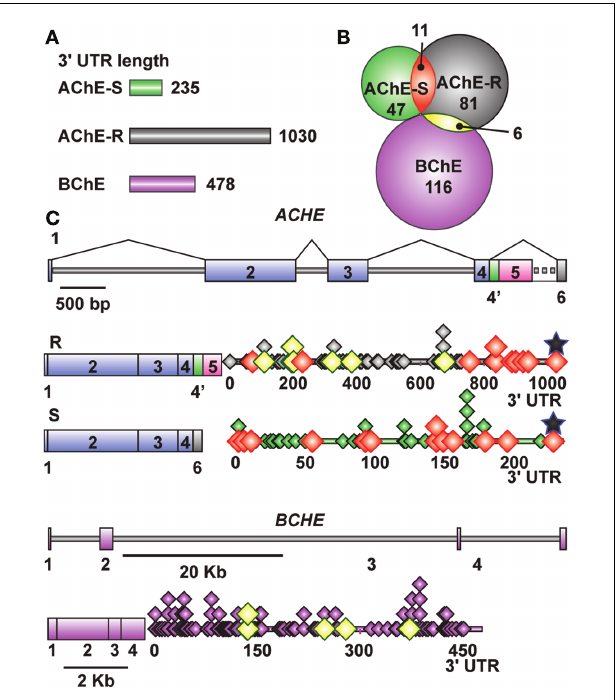
FIGURE 2 | Cholinesterase-targeted miRs show distinct 3 (cid:2) UTR distributions and partial overlaps. (A) The length of the studied 3 (cid:2) UTR domains. (B) Each 3 (cid:2) -UTR is targeted by many different miRs, part of which shared by BChE/AChE-R and AChE-R/AChE-S. (C) Gene and transcript compositions (exons shown as boxes, introns – as lines) and miR distribution patterns on the 3 (cid:2) -UTR domain (not to scale). Overlaps are color coded. MiR (diamonds) localizations are marked. Black stars show miR-132